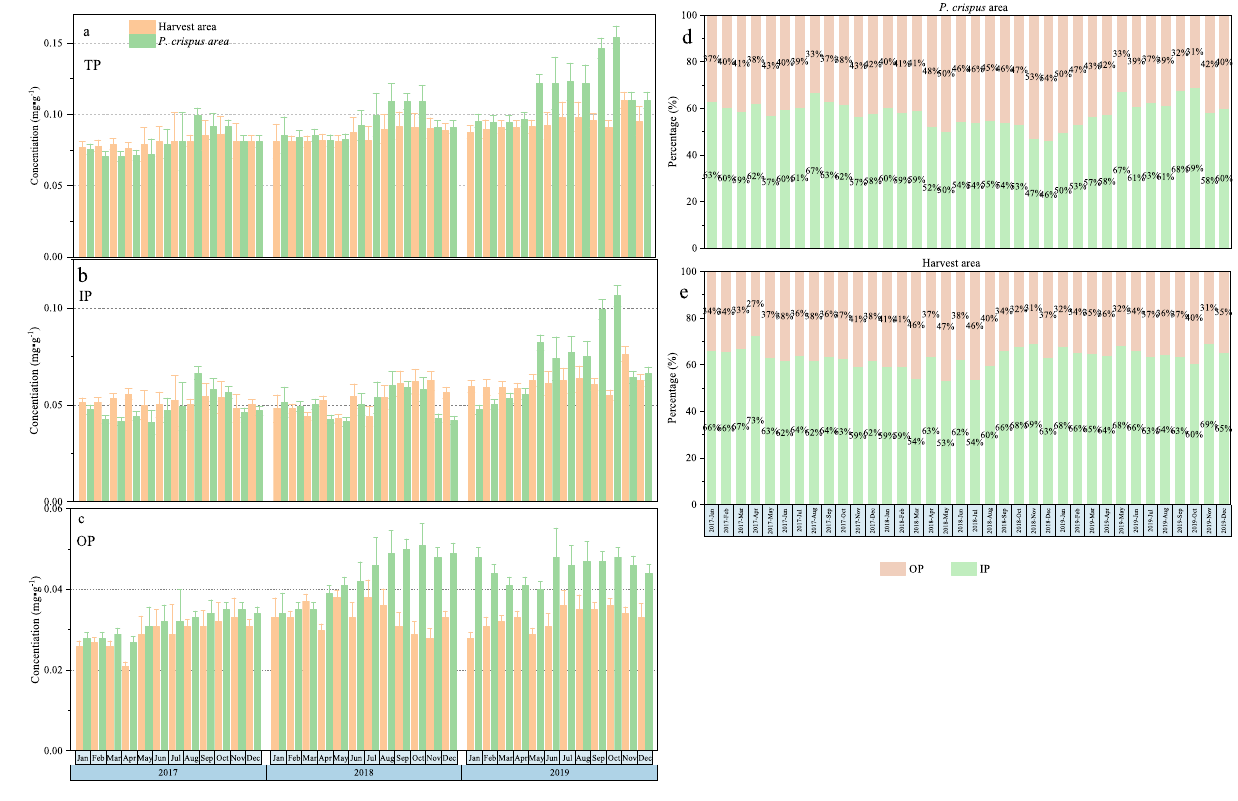
Figure 3. Monthly variations of sediment P fractions (mean ± SD) in different areas of Yimeng Lake from January 2017 to October 2019. a–c different P fractions in sediment. d percentage of IP and OP in the harvest area, e percentage of IP and OP in the P. crispus area.